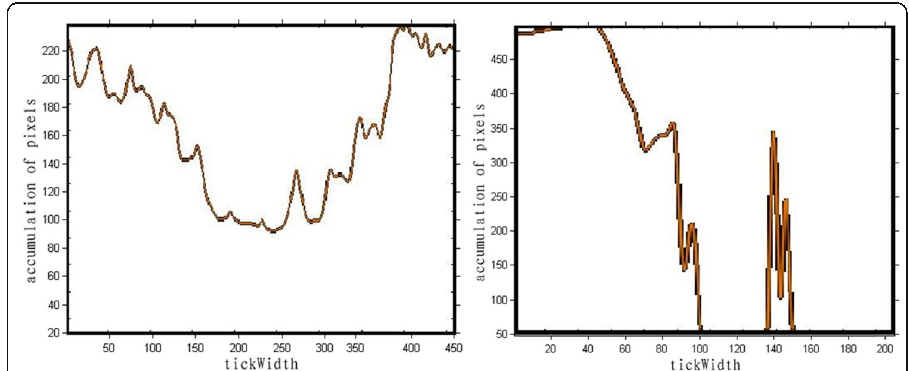
Fig. 5 Example of integration projection based on normal echo